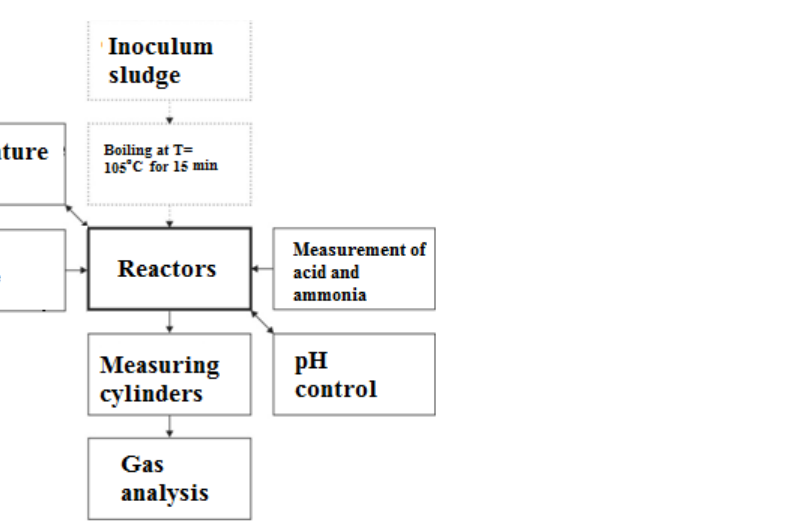
Figure 1. Scheme of Fermentation setups used in the experiment [56] (Reproduced with permission from Sołowski Heliyon Elsevier 2021).